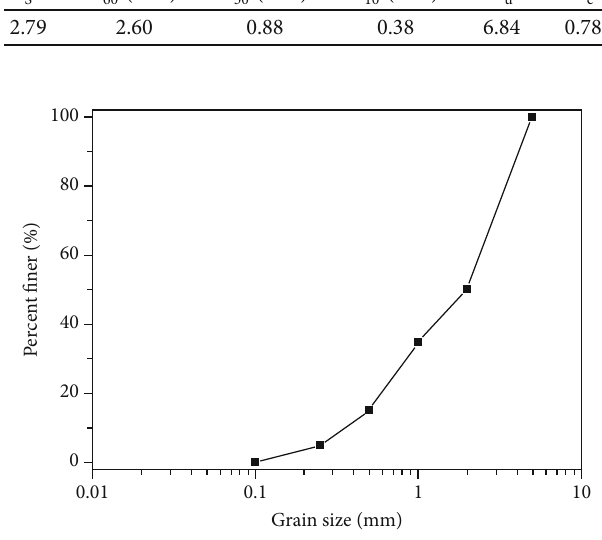
Figure 2: Grain size distribution curves of calcareous